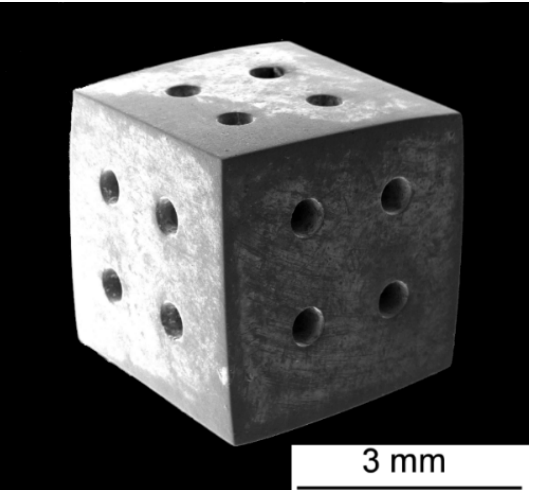
Figure 2. Example of a cubic scaffold, with 0.5 mm holes, used in the present investigation. Each scaffold was immersed in approximately 200 mL of Hank’s solution for 14 days at room temperature. A funnel was used to collect H 2 and the volume of gas was